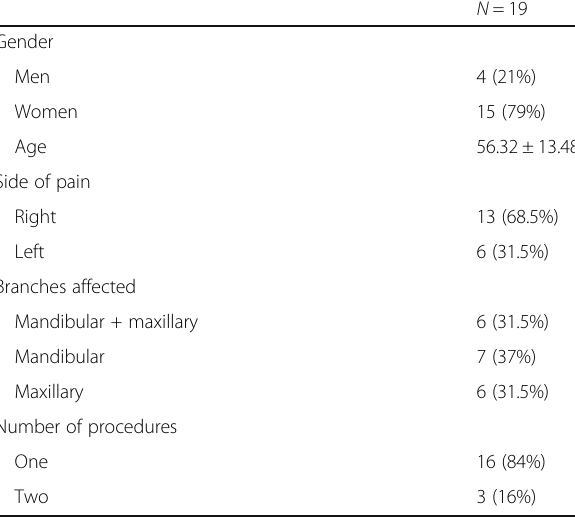
Table 1 General characteristics of the study